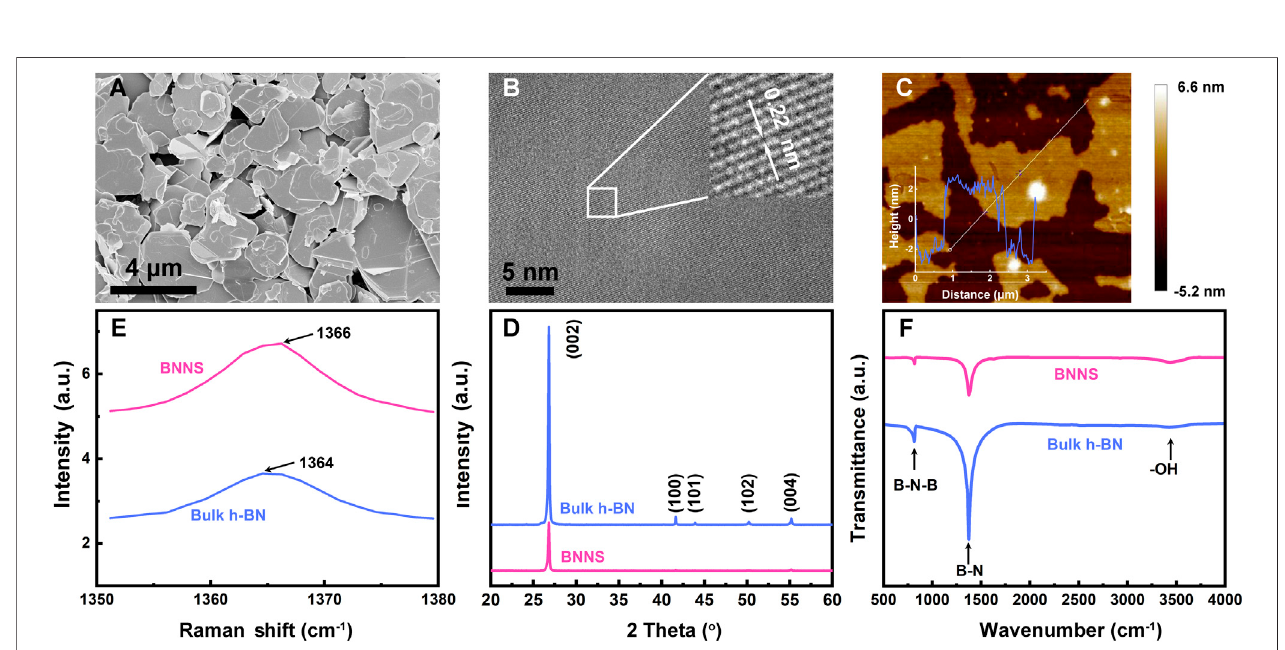
FIGURE 2 | Characterization of BNNS and BN powders: (A) SEM, (B) TEM, (C) AFM, (D) Raman, (E) XRD, and (F) FTIR spectra.